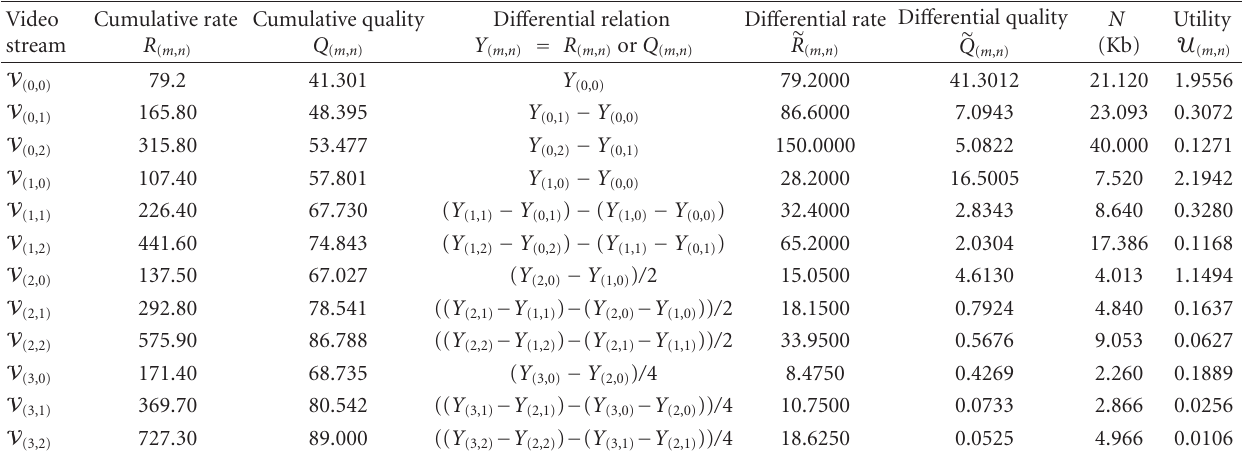
Table 1: Calculation bit rate for SVC video with 4 temporal and 3 quantization layers for Crew video. Video